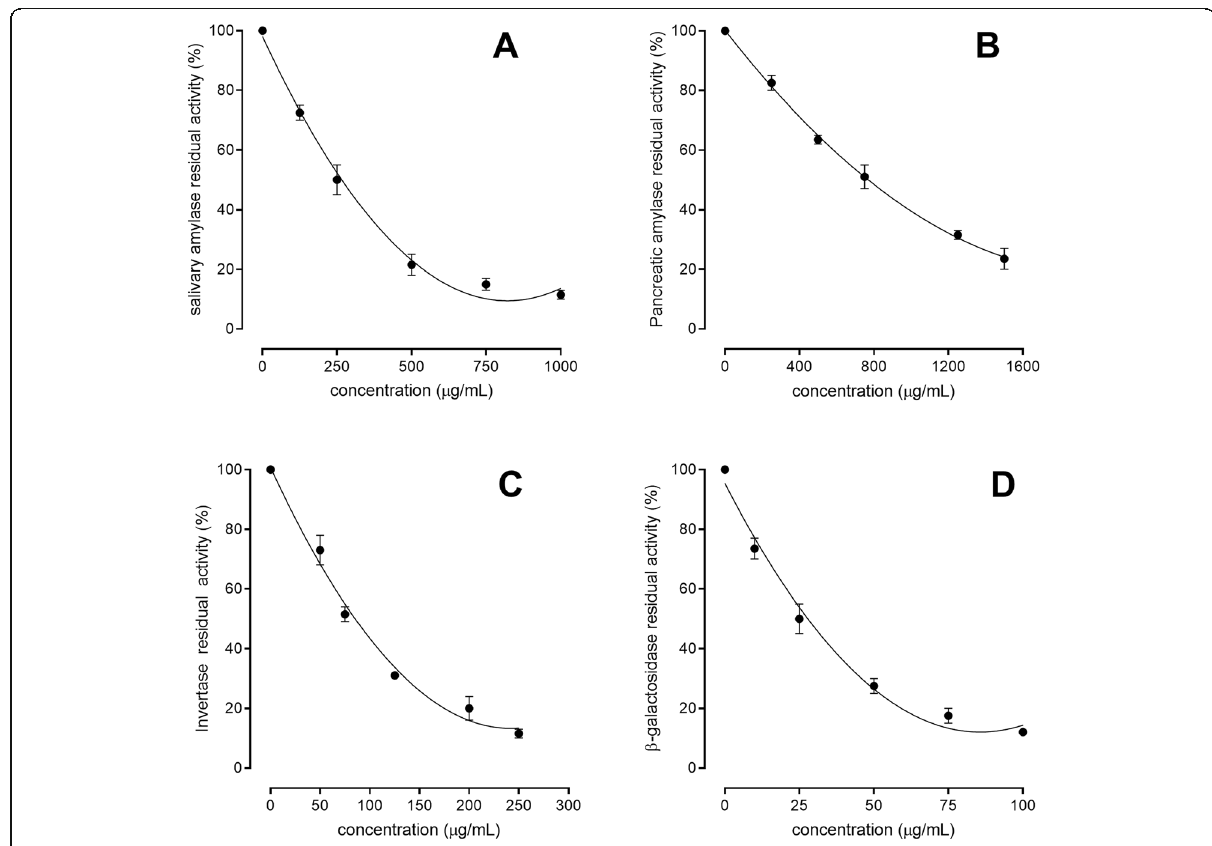
Fig. 1 The inhibitory effects of the aqueous alcohol extract of P. pluviosa on carbohydrate digestive enzymes relevant to type 2 diabetes: a salivary α -amylase; b pancreatic α -amylase; c intestinal invertase; d intestinal β -galactosidase. Results are expressed as mean ± mean standard errors of three